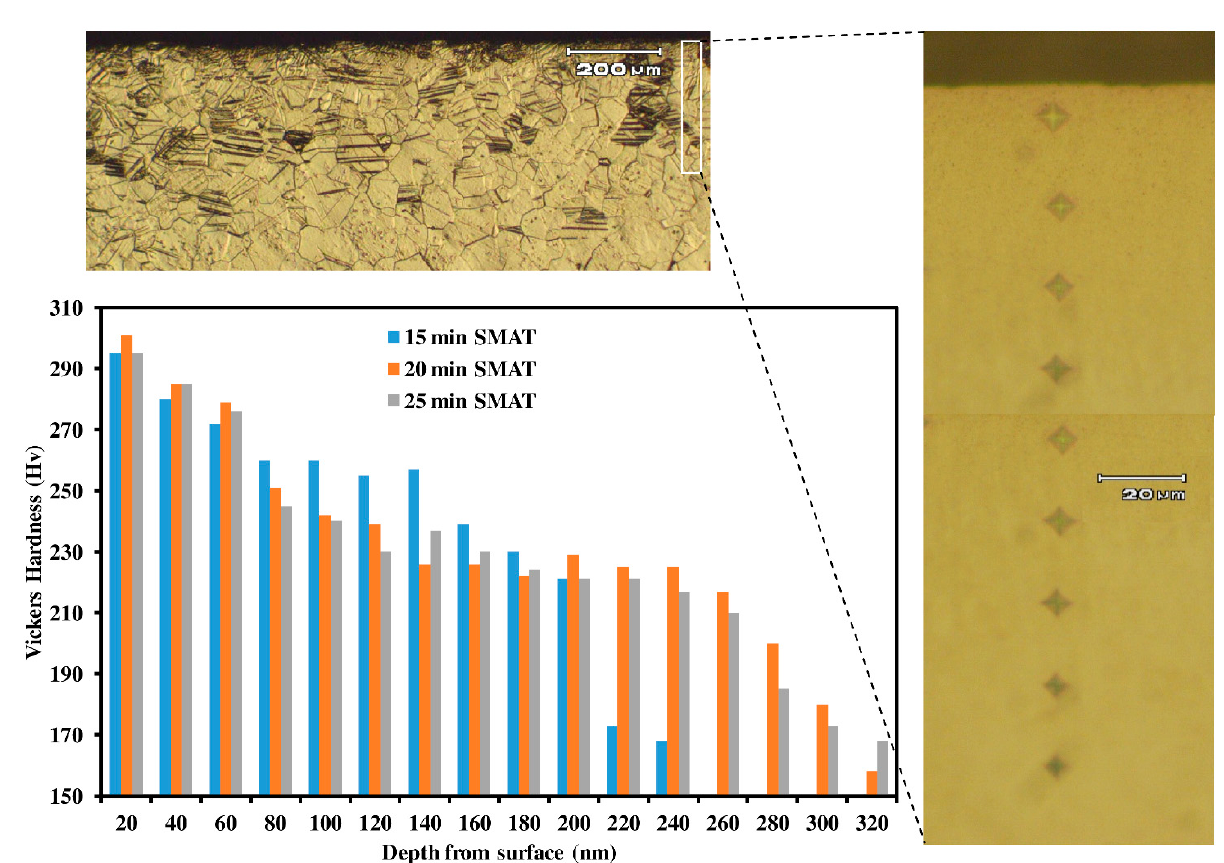
Figure 6. Vickers hardness profile as a function of depth from surface for samples with 15 min, 20 min and 25 min SMAT time.